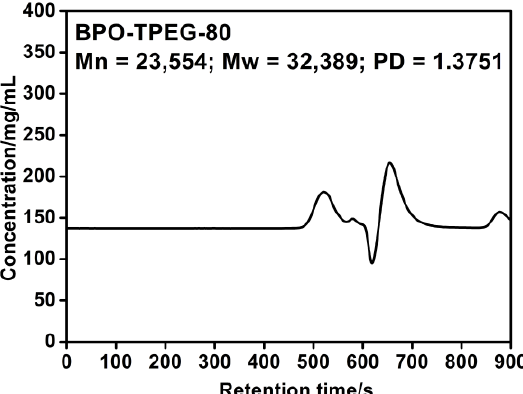
Figure 3. Molecular weight of PCE (initiator: BPO; PCE samples: